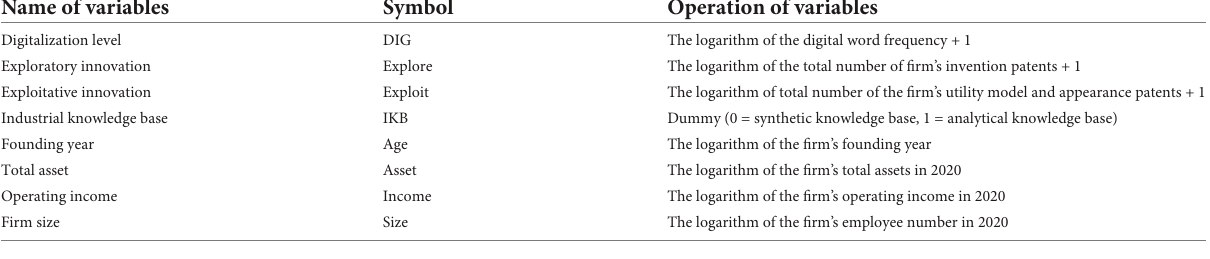
TABLE 2 Description of key variables.